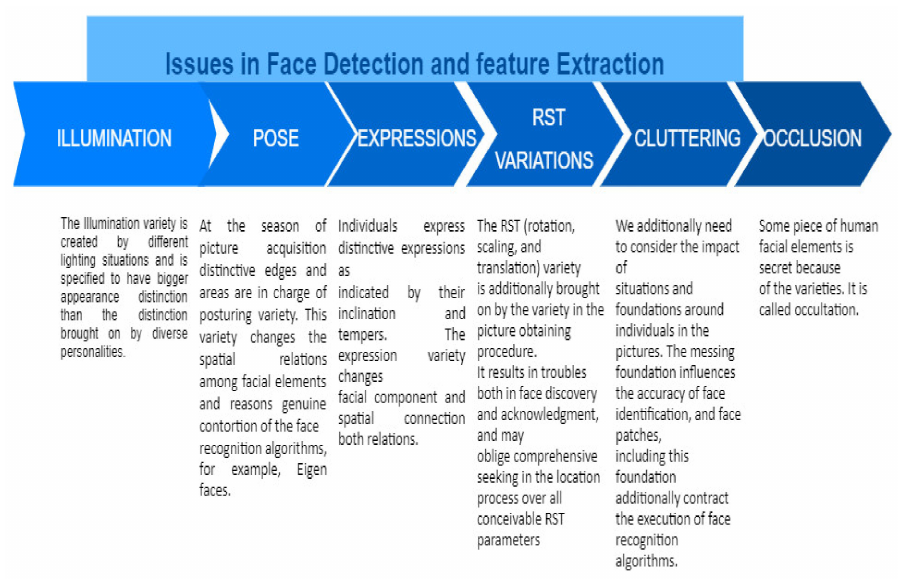
Figure 2. Issues in face detection and feature